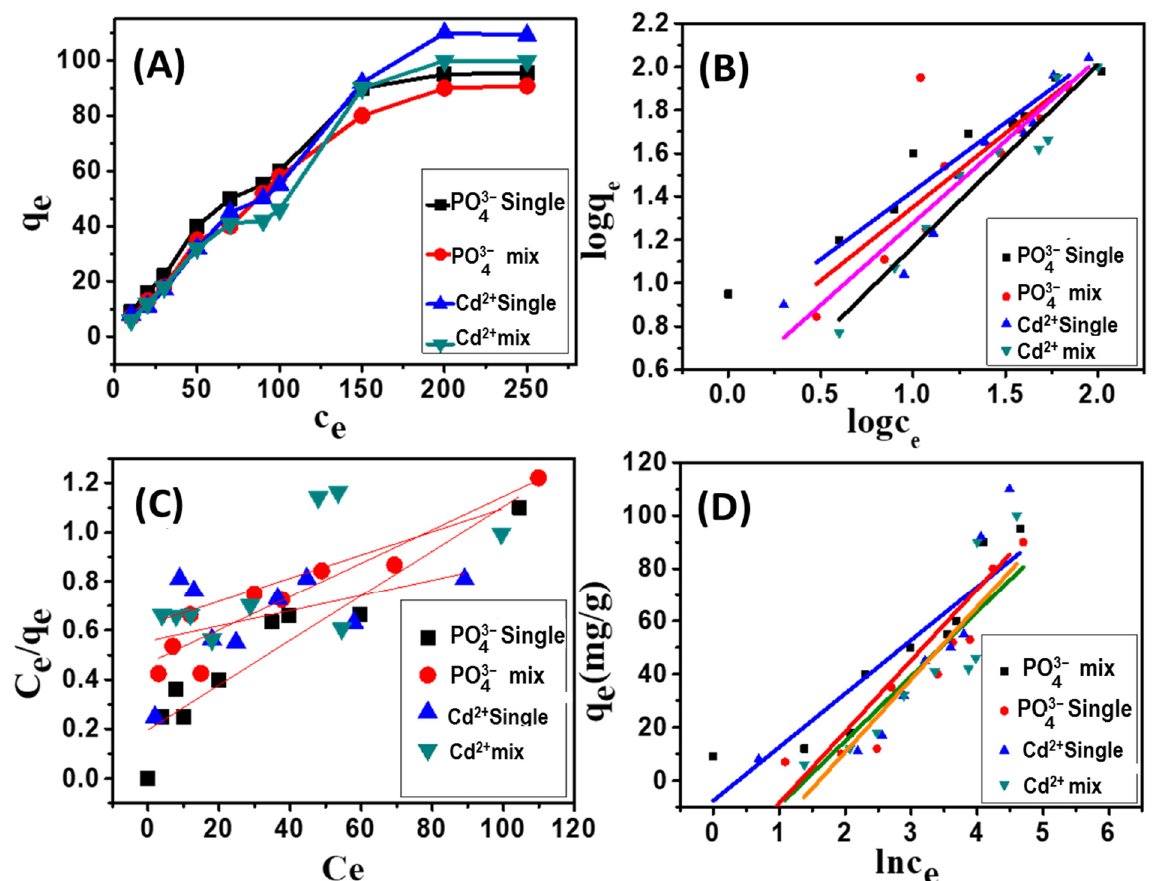
Figure 10. Equilibrium studies of Cd 2+ and PO 43- adsorption using the synthetic composite; effect of the initial concentration on the adsorption capacity ( A ), Freundlich isotherm model ( B ), Langmuir isotherm model ( C ), and Temkin isotherm model ( D ).